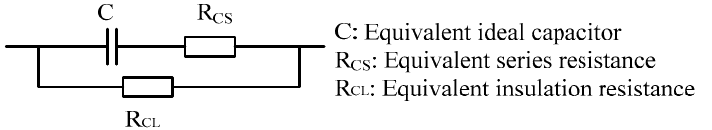
Figure 9. Simplified equivalent model of the supercapacitor.